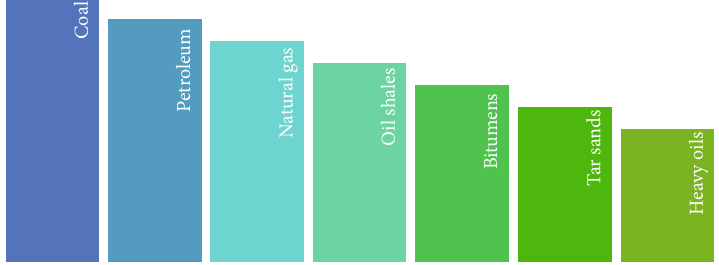
Figure 1: Fossil